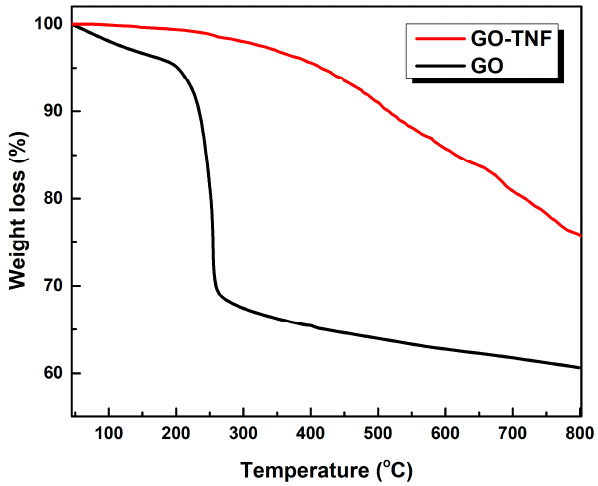
Figure 8. TGA curves of GO (black) and GO-TNF (red) taken under N 2 atmosphere and 10 °C/min heating rate.